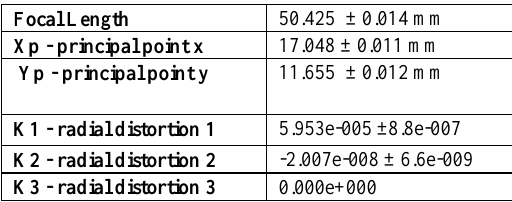
Table 1. Camera calibration coefficients